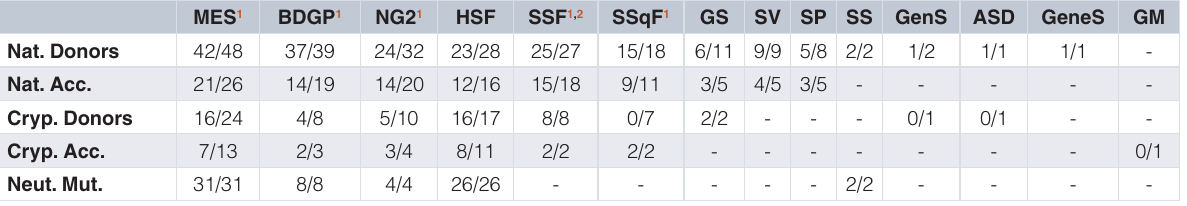
Table 2a. Concordance of splice-prediction programs to information theory-based tools for natural and cryptic